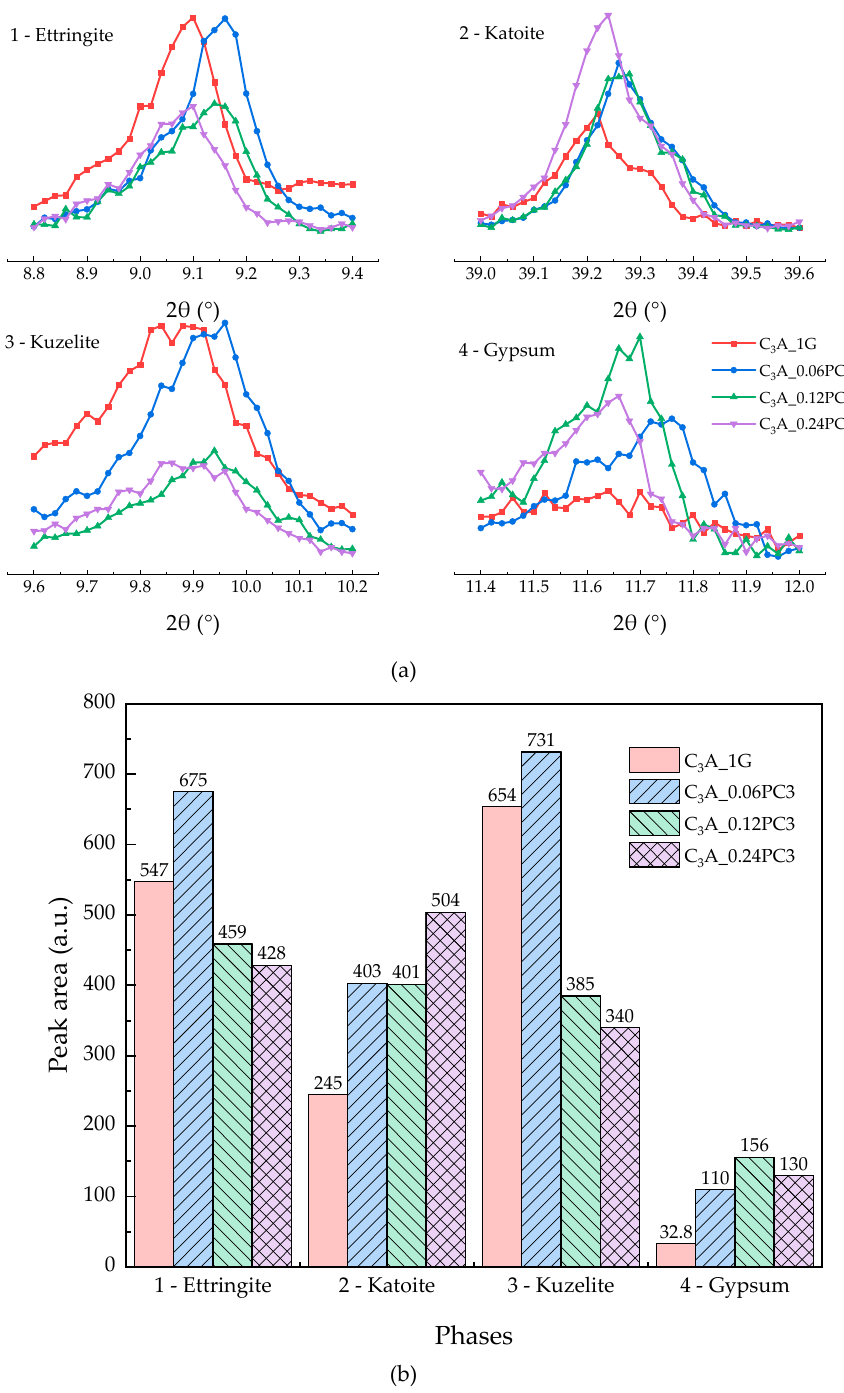
Figure 9. ( a ) XRD patterns of phases obtained from C 3 A-gypsum with different concentrations of PC3 solution after the 24-h hydration. ( b ) XRD peak area of each phase in (a).